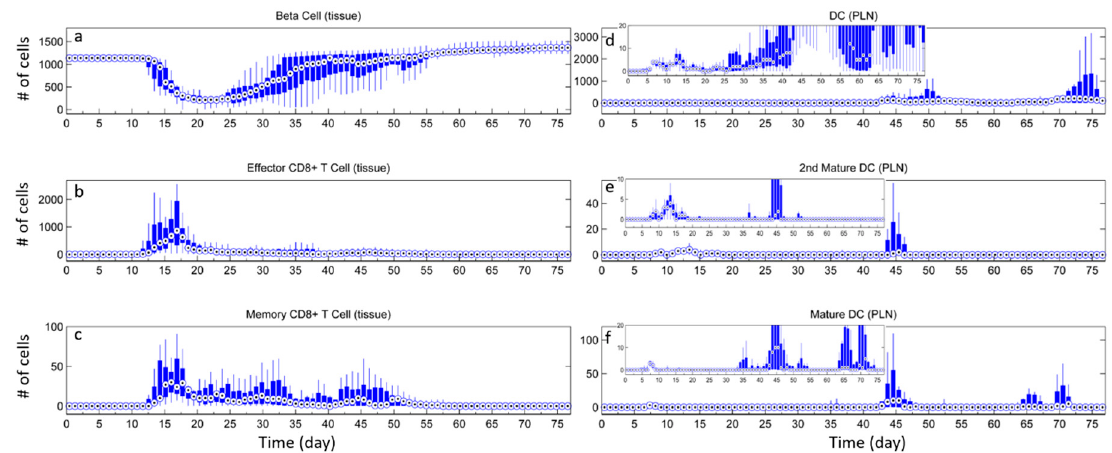
Figure A3. Simulation results for case with induced Tregs (case IV). There are no initial Tregs but conversion ability of CD4 + T cells. The number of ( a ) β cells, ( b ) effector CD8 + T cells, ( c ) memory CD8 + T cells- in pancreatic tissue are shown on the left column. The number of ( d ) total DCs, ( e ) 2nd mature DCs, ( f ) mature DCs in PLN are shown on the right column. Inserts (number of cells vs. time) show small change of cell number in the bottom figures. t = 0 days correspond to 3-week age of mouse.